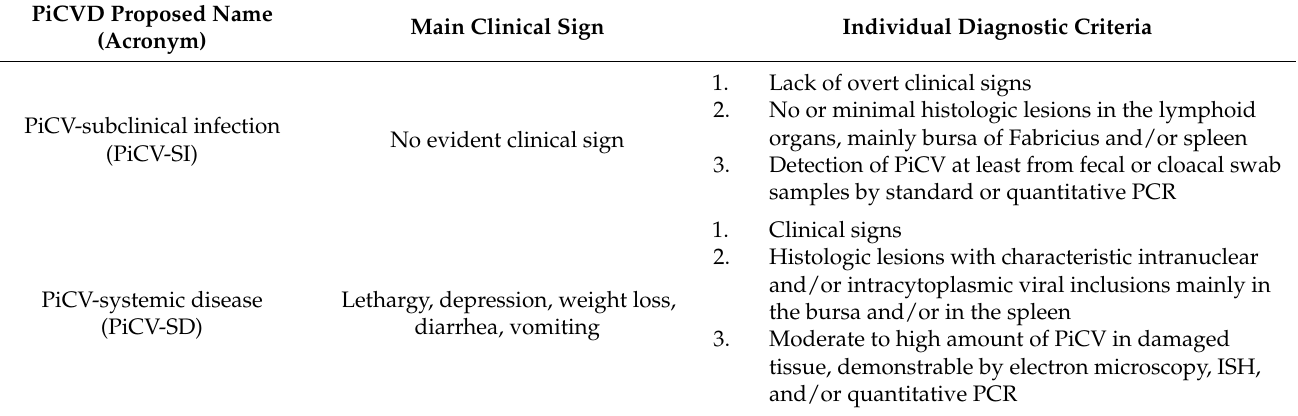
Table 3. Proposed terminology for pigeon circovirus diseases together with their case definition based on clinical and laboratorial